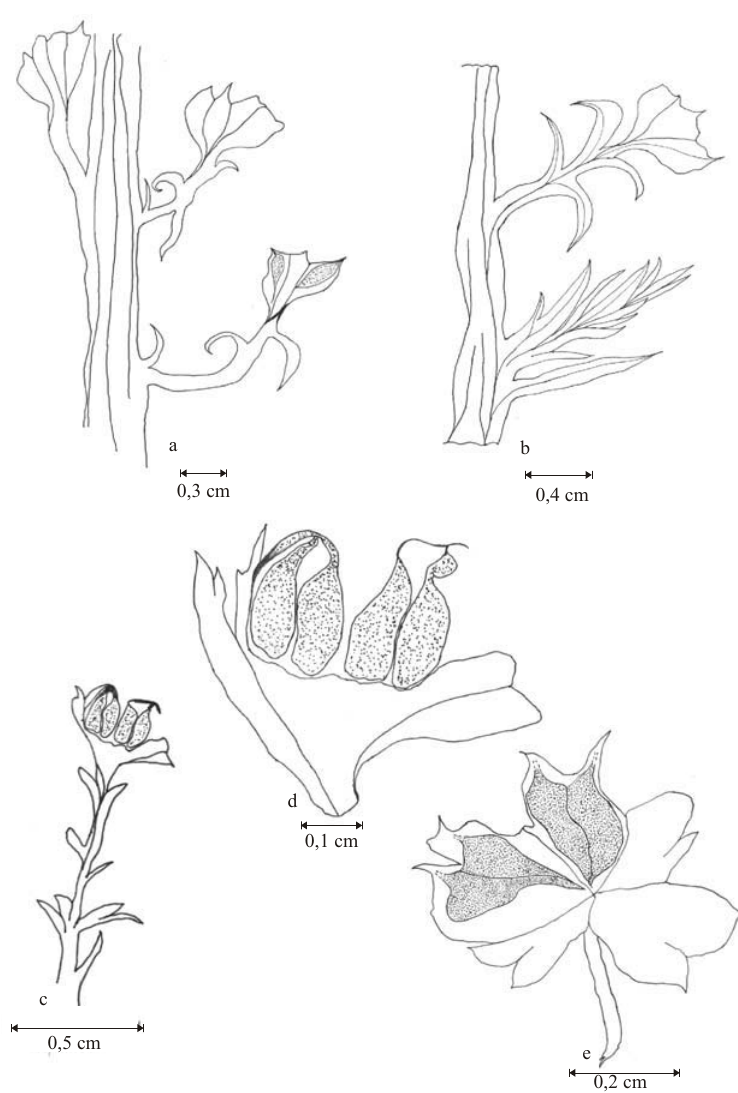
Fig. 4 – Coricladus quiteriensis sp. nov. reproductive branches from Quitéria outcrop: (a) reproductive branches coming from the leafless principal branches, presenting scarce leaves – PbU 073; (b) reproductive and vegetative branches, coming from the same leafless principal branch – PbU 075; (c) detail from a reproductive branch with bracteal scales, associated to ovuliferous scales at the apical portion – PbU 222; (d) lateral detail from a cone with seeds – PbU 222; (e) detail from a cone with 4 (four) ovuliferous scales radially and circular-plane disposed around the axis, with the presence of 4 (four) elliptically elongated seeds (two/scale) – PbU